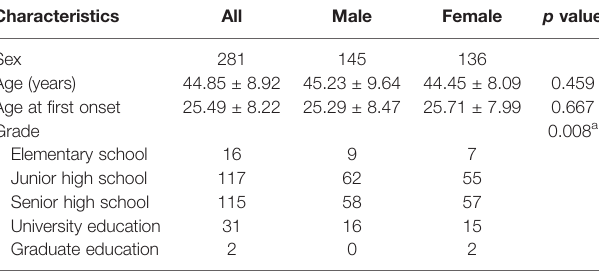
TABLE 1 | General characteristics of the study participants. Characteristics